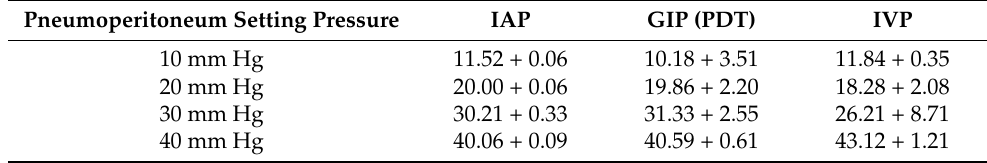
Table 1. The average pressure data from different measuring tools under pneumoperitoneum pressure. Figure 6. Relationship between the intravesical pressure detected by the pressure probe (brown) and PressureDot (blue) showing a with high correlation, R = 0.9498.